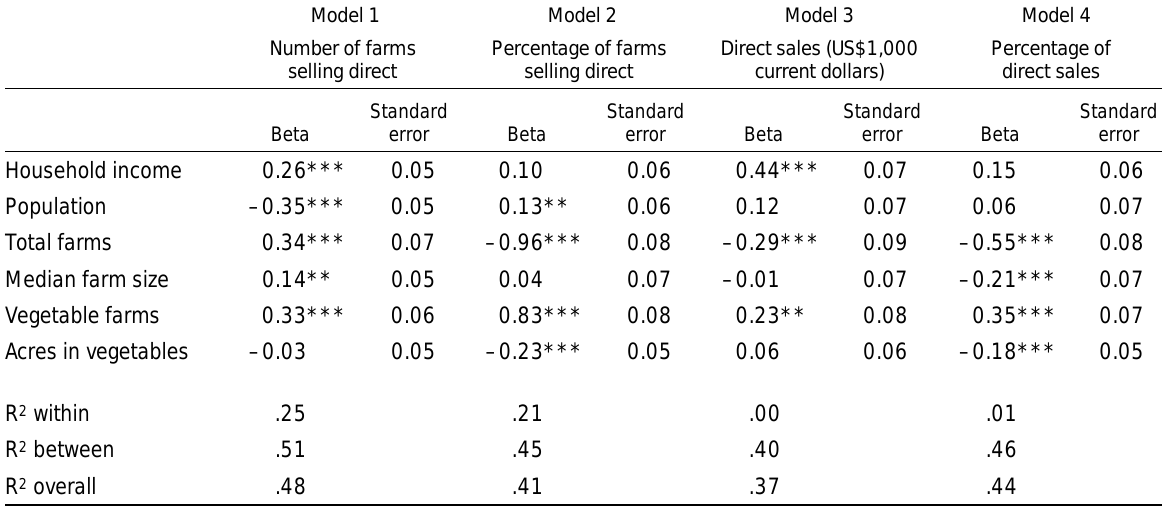
Table 3. Fixed-effects